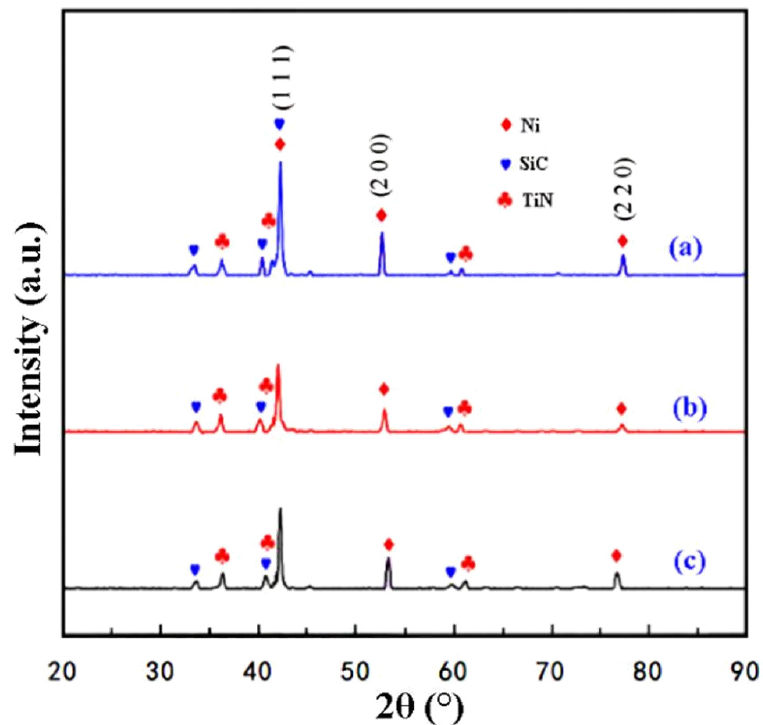
Figure 6. XRD patterns for Ni/TiN-SiC nanocomposites prepared using diverse pulse current densities: ( a ) 2 A/dm 2 , ( b ) 4 A/dm 2 , and ( c ) 6 A/dm 2 .